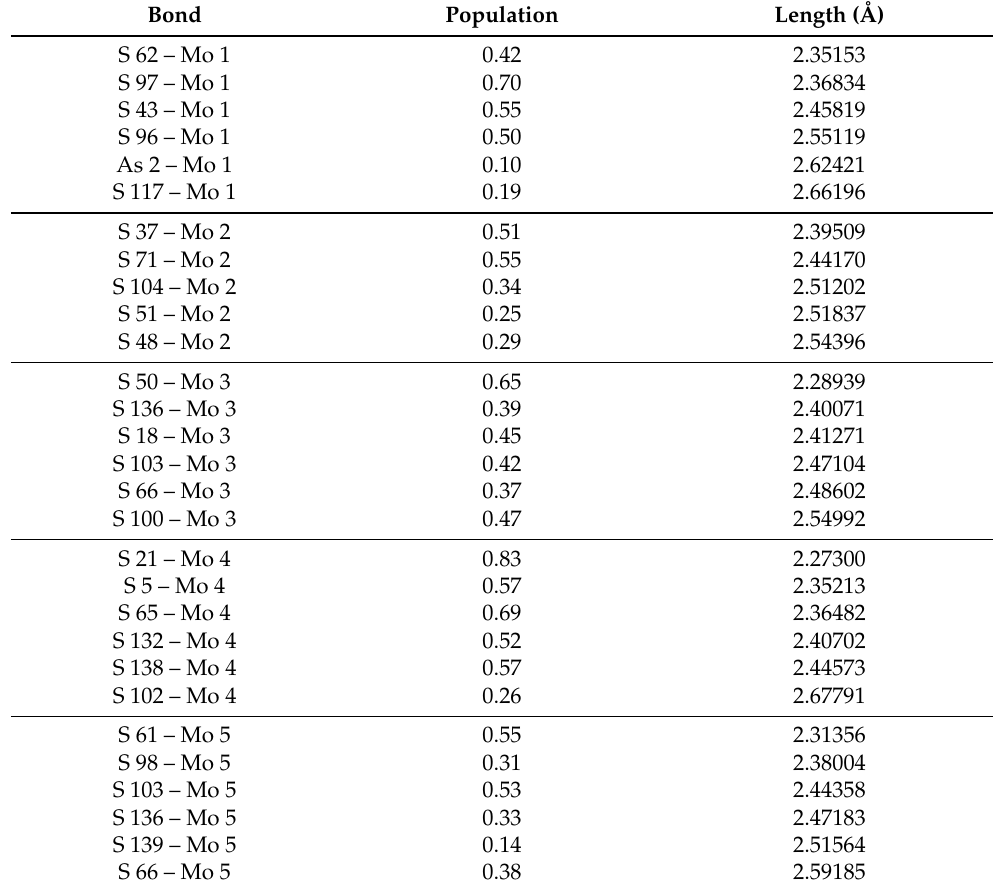
Table A7. Bond populations for mq As 2 S 3 :Mo.